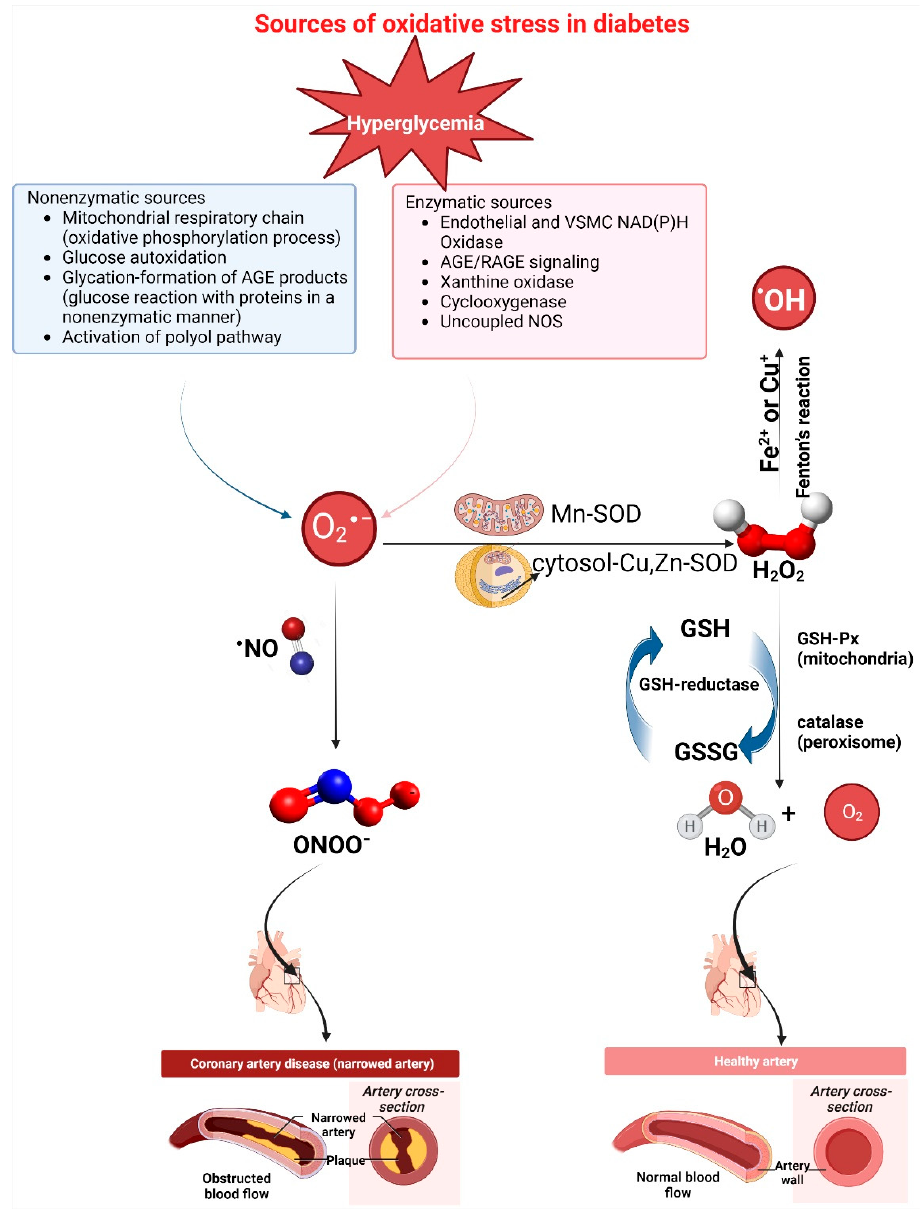
Figure 6. Generation of reactive species in DM. Some of the essential ROS and RNS are shown in the picture. Oxygen is converted to O 2 ·− via the activation of enzymatic and non-enzymatic pathways, which is then dismutated to H 2 O 2 by the superoxide dismutase (SOD). H 2 O 2 can be converted to H 2